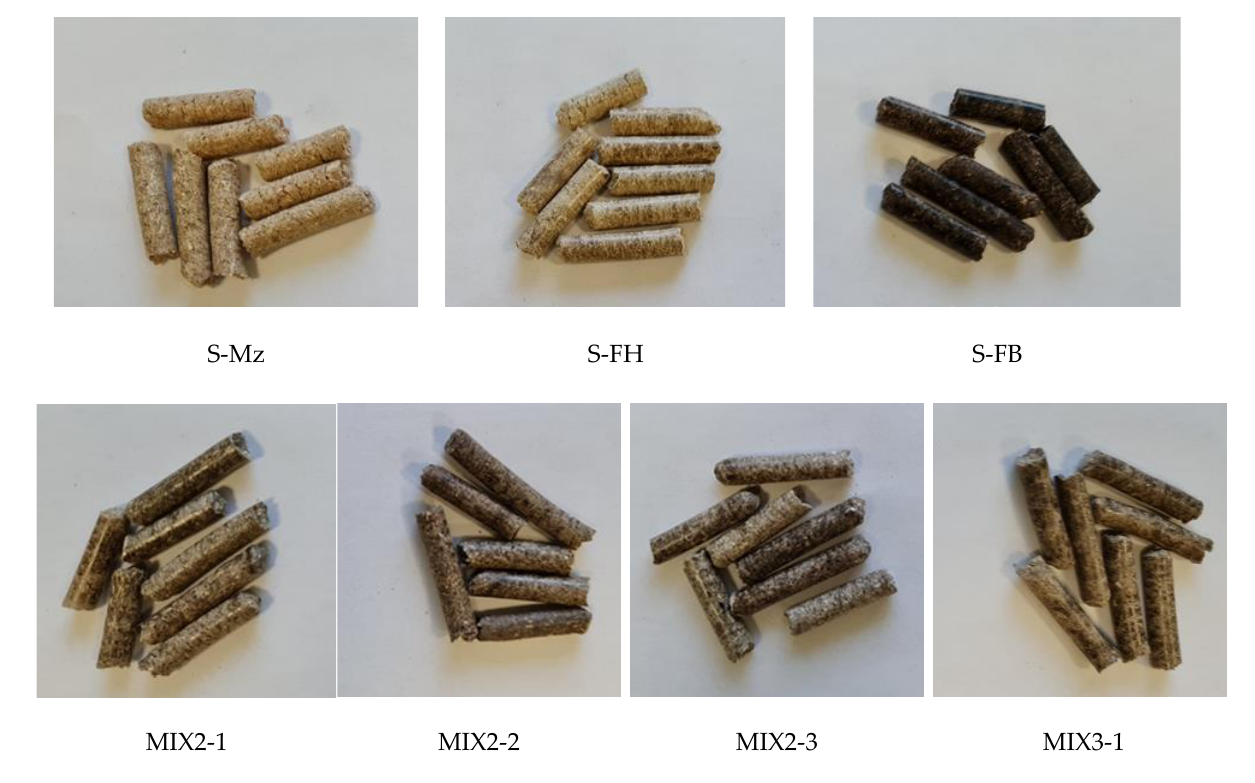
Figure 2. Samples of produced pellets.